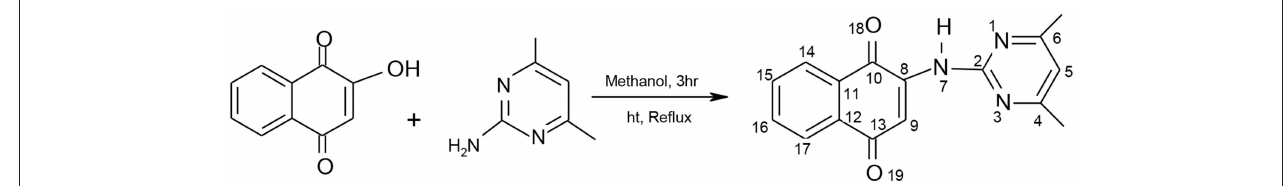
SCHEME 1 | Synthetic Scheme of HL Schiff